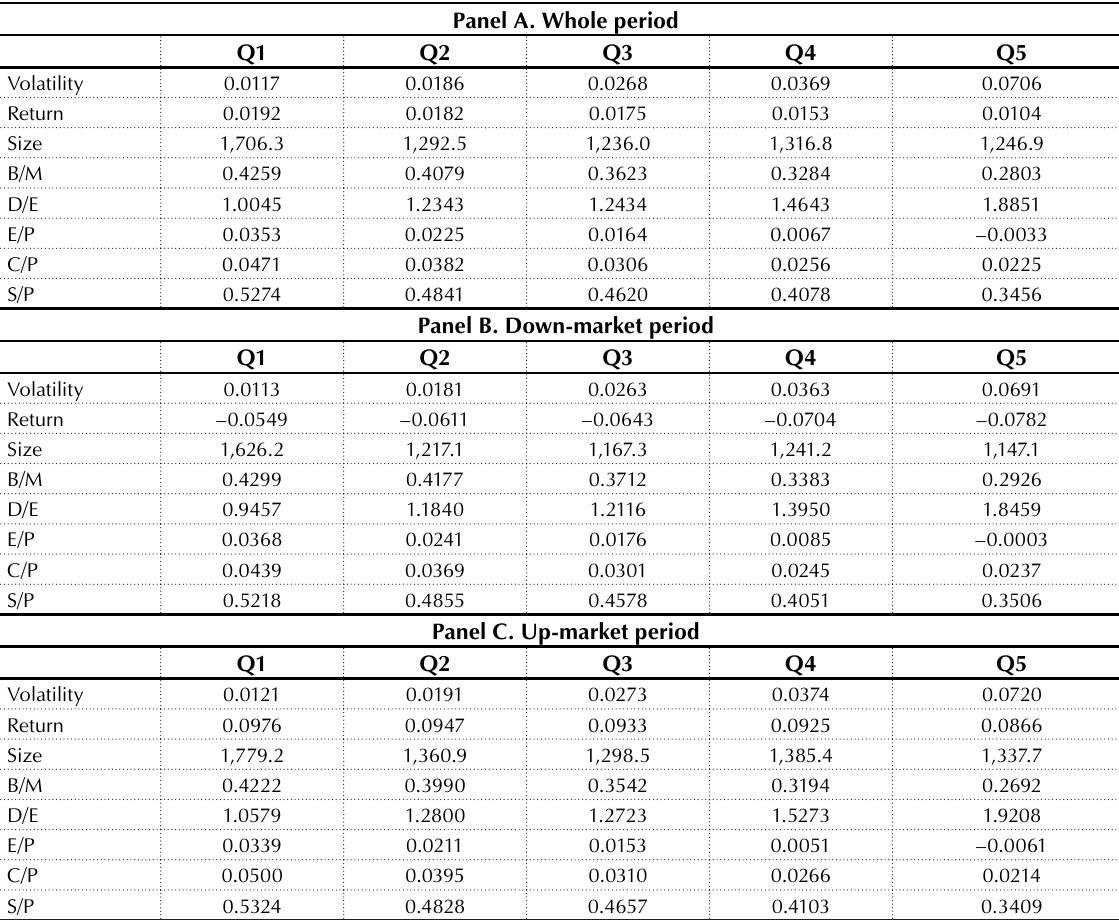
Table 7. Average characteristics for quintile portfolios formed on total volatility from 1995 through 2008